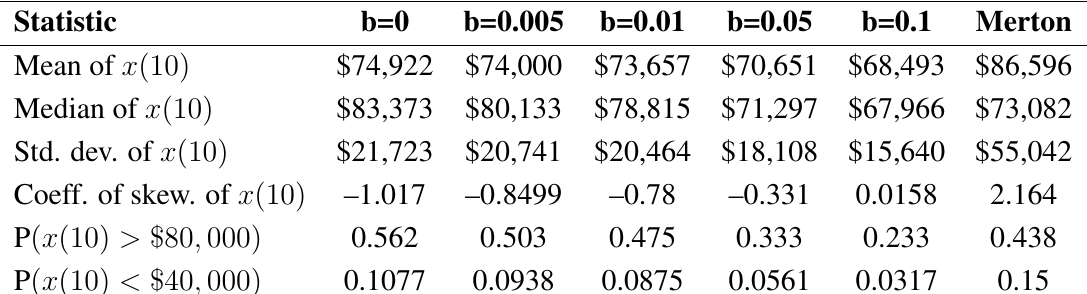
Figure 8. Fund value cumulative and probability distribution functions for various values of b . Table 2. Pension distributions